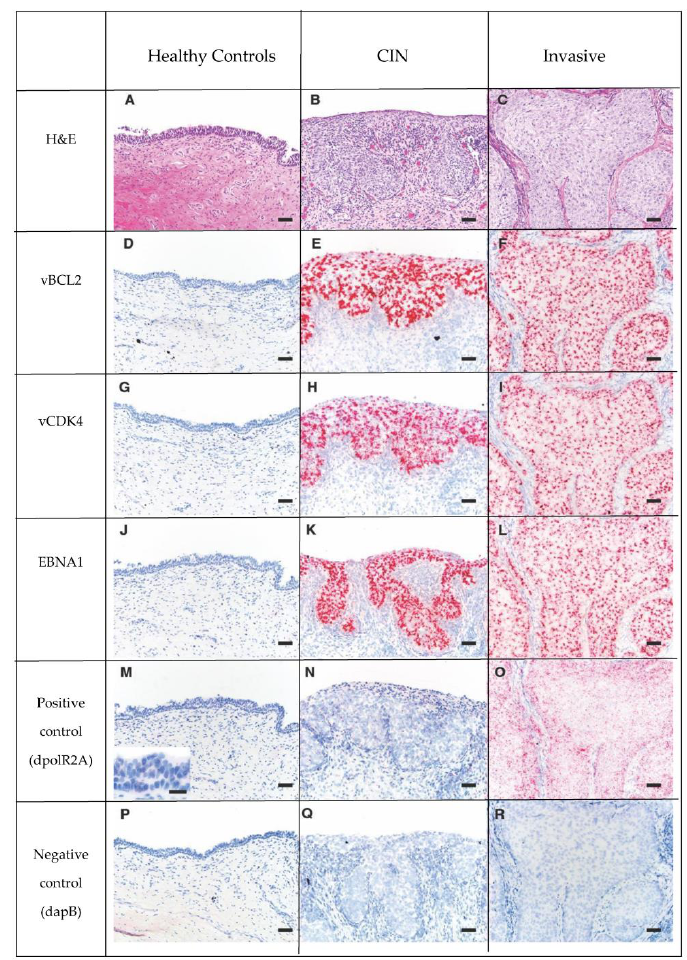
Figure 3. Series of H&E (Row 1: A – C ) and RISH (Basescope ® ) labeled tissue (Rows 2 to 6: D through R), pink dots represent positive hybridization signaling. Rows 2, 3 and 4 are 3 OtHV1 RISH probes (Row 2- vBCL2, Row 3- vCDK4, Row 4-EBNA1). Row 5 is the positive control, California sea lion DNA-dependent RNA polymerase II (dpolR2A). Row 6 is the negative control dihydrodipicolinate reductase (dapB) of Bacillus subtilis . Note that there is no positive hybridization signal of the OtHV1 probes in the normal cervix ( D , G , J ), and there is a large amount of positive hybridization signaling in both the CIN (Column 2) and invasive (Column 3) lesions from cases with urogenital carcinoma. This shows that there is high OtHV1 mRNA expression in both CIN and invasive cervical tumors, but not in normal cervical epithelium. There was no positive hybridization signal in the negative control (Row 6) for control, CIN or invasive